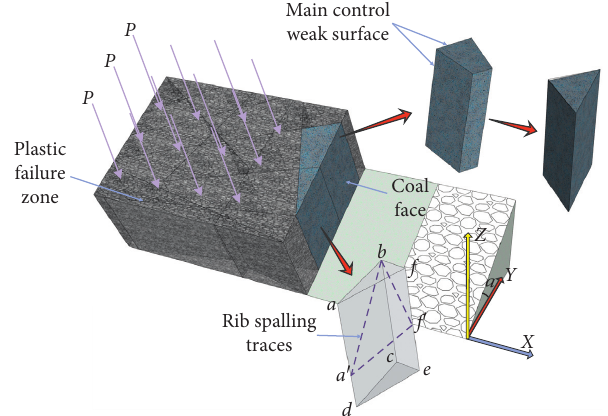
Figure 7: Physical-mechanical model of the coal wall.